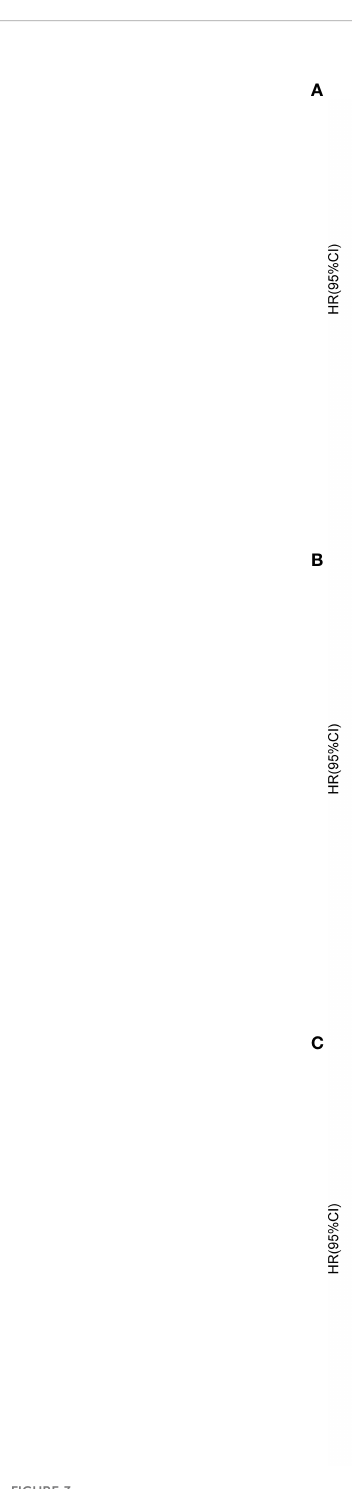
FIGURE 3 Dose-response associations of METS-IR with total stroke (A) , ischemic stroke (B) , and hemorrhagic stroke (C)